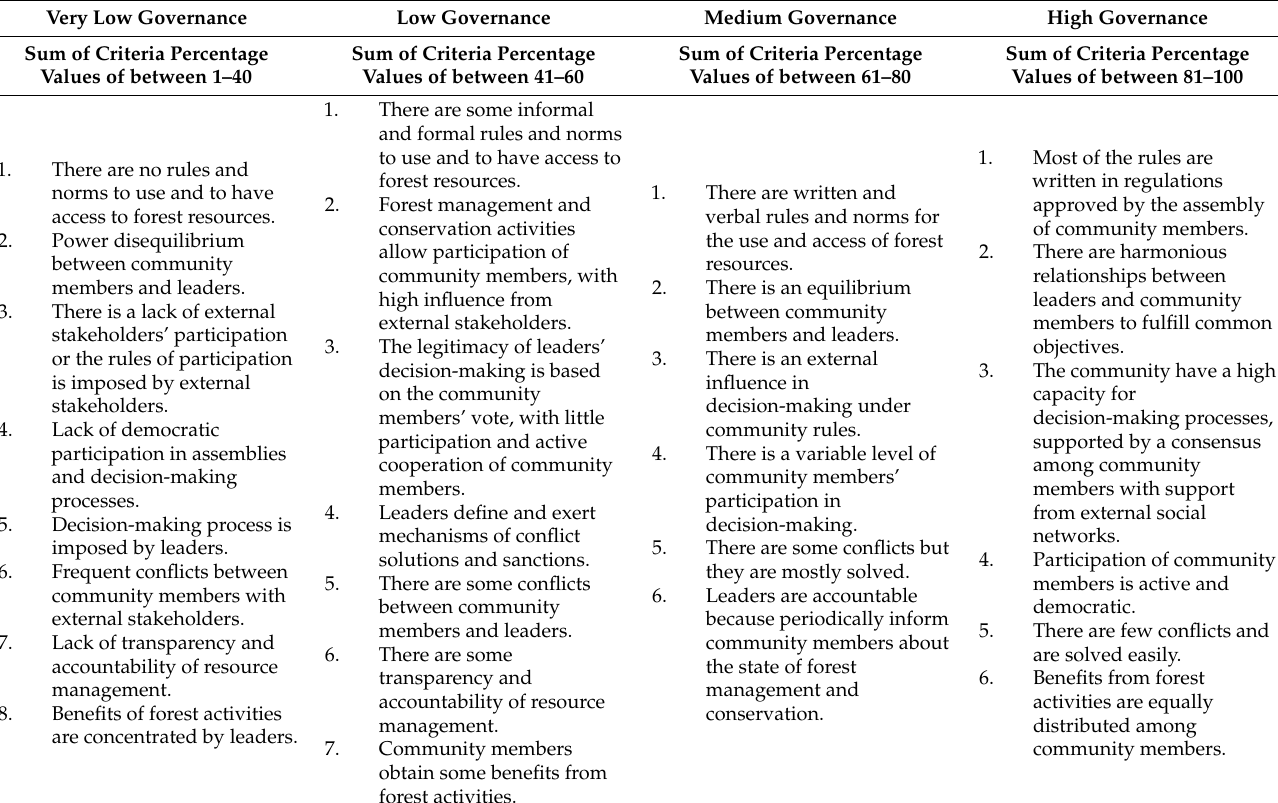
Table 6. Definitions of levels of community forest